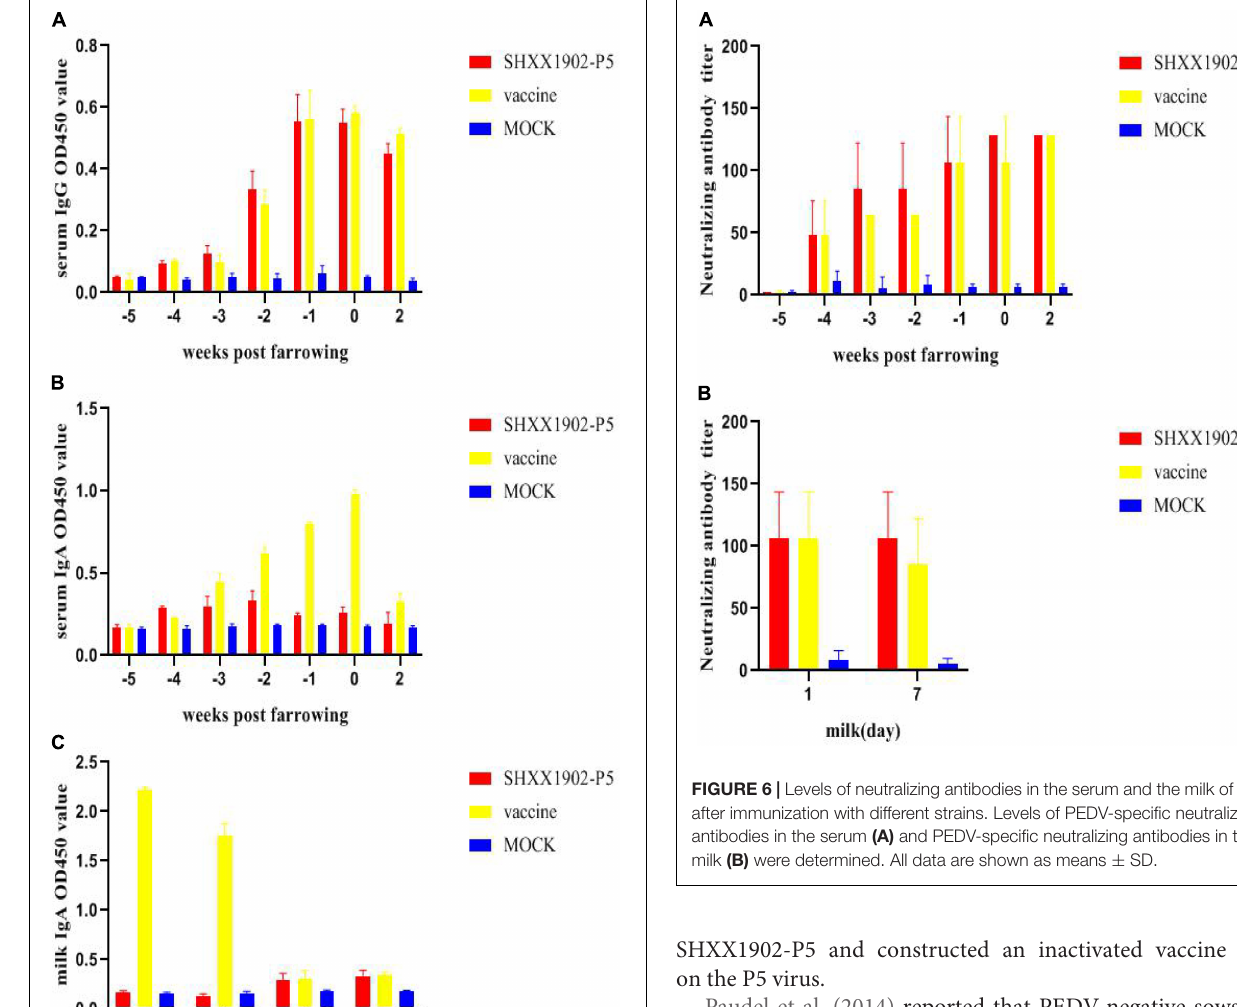
SHXX1902-P5 and constructed an inactivated vaccine based on the P5